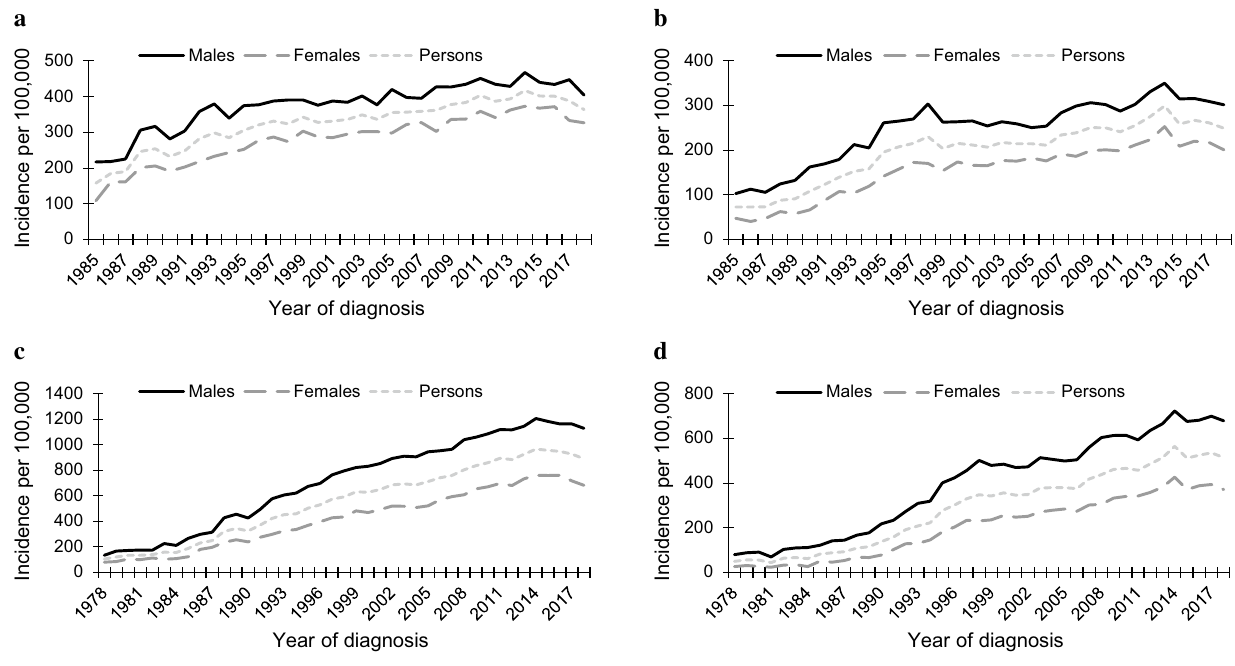
Fig. 1 Temporal trends in the incidence rates of keratinocyte carcinoma in Tasmania, by histological type and sex. Incidence rates are stand- ardised to the Australian 2001 population. a First basal cell carcinoma, 1985–2018; b first squamous cell carcinoma, 1985–2018; c annual basal cell carcinoma, 1978–2018; d annual squamous cell carcinoma,